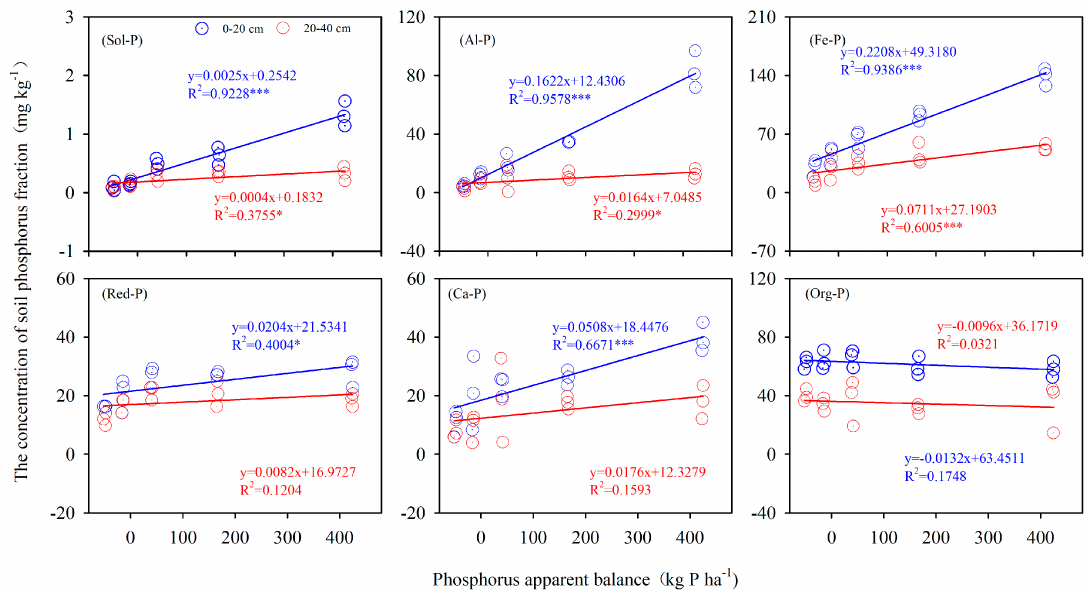
Figure 5. Relationship between PAB and soil P fractions comes from the field experiment. Note: * means p < 0.05, *** means p < 0.001.